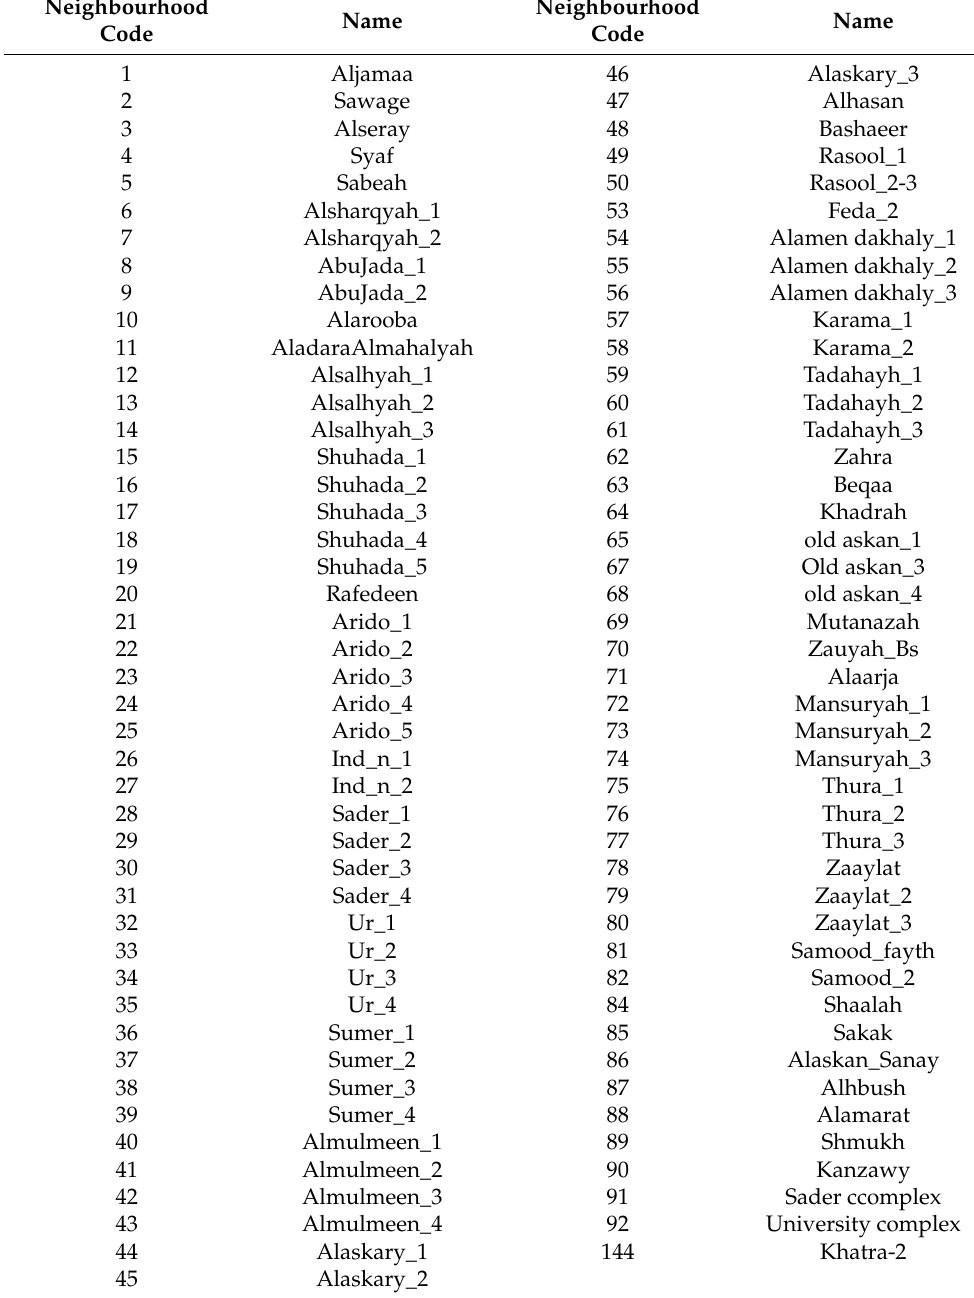
Table A1. The codes and names of the neighbourhoods of Nasiriyah City in south